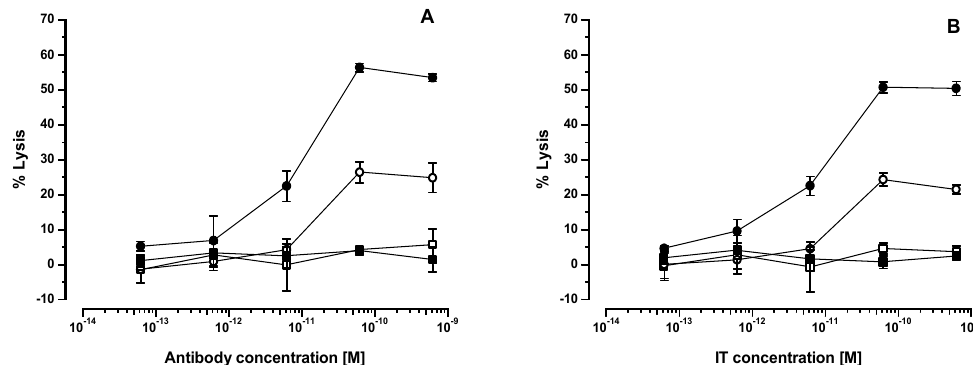
Figure 4. Lysis of target HSB-2 cells in a 56 Cr release assay by splenocytes at a 1:100 T:E ratio from untreated SCID mice (open symbols) or following treatment 24 h previously with 100 µ g [poly (I:C)] i.v. (closed symbols) in the presence of varying concentrations of ( A ) intact HB2 antibody ( , ● ), or Fab 2 HB2 antibody ( □ , ■ ) or ( B ) HB2-SAPORIN IT ( , ● ), HB2-F(ab’) 2 -SAPORIN ( □ , ■ ).